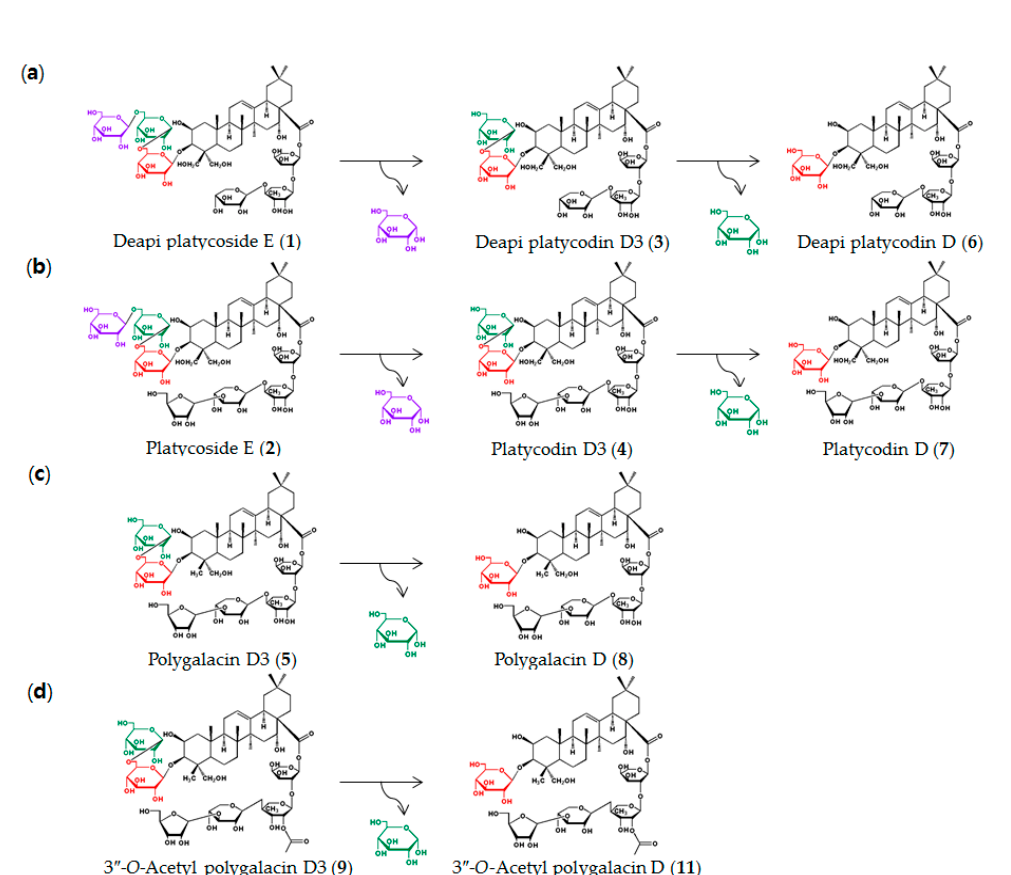
Figure 2. Pathways involved in the biotransformation of platycosides into deglucosylated platycosides by β -glucosidase from Caldicellulosiruptor bescii. ( a ) Biotransformation of deapiosylated (deapi)-platycoside E (1) into deapi-platycodin D (6) via deapi-platycodin D3 (3). ( b ) Biotransformation of platycoside E (2) into platycodin D (7) via platycodin D3 (4). ( c ) Biotransformation of polygalacin D3 (5) into polygalacin D (8). ( d ) Biotransformation of 3”- O -acetyl polygalacin D3 (9) into 3”- O -acetyl polygalacin D (11). β -Glucosidase from Caldicellulosiruptor bescii catalyzed the deglucosylation of only the two outer glucose molecules at C-3 of platycosides.